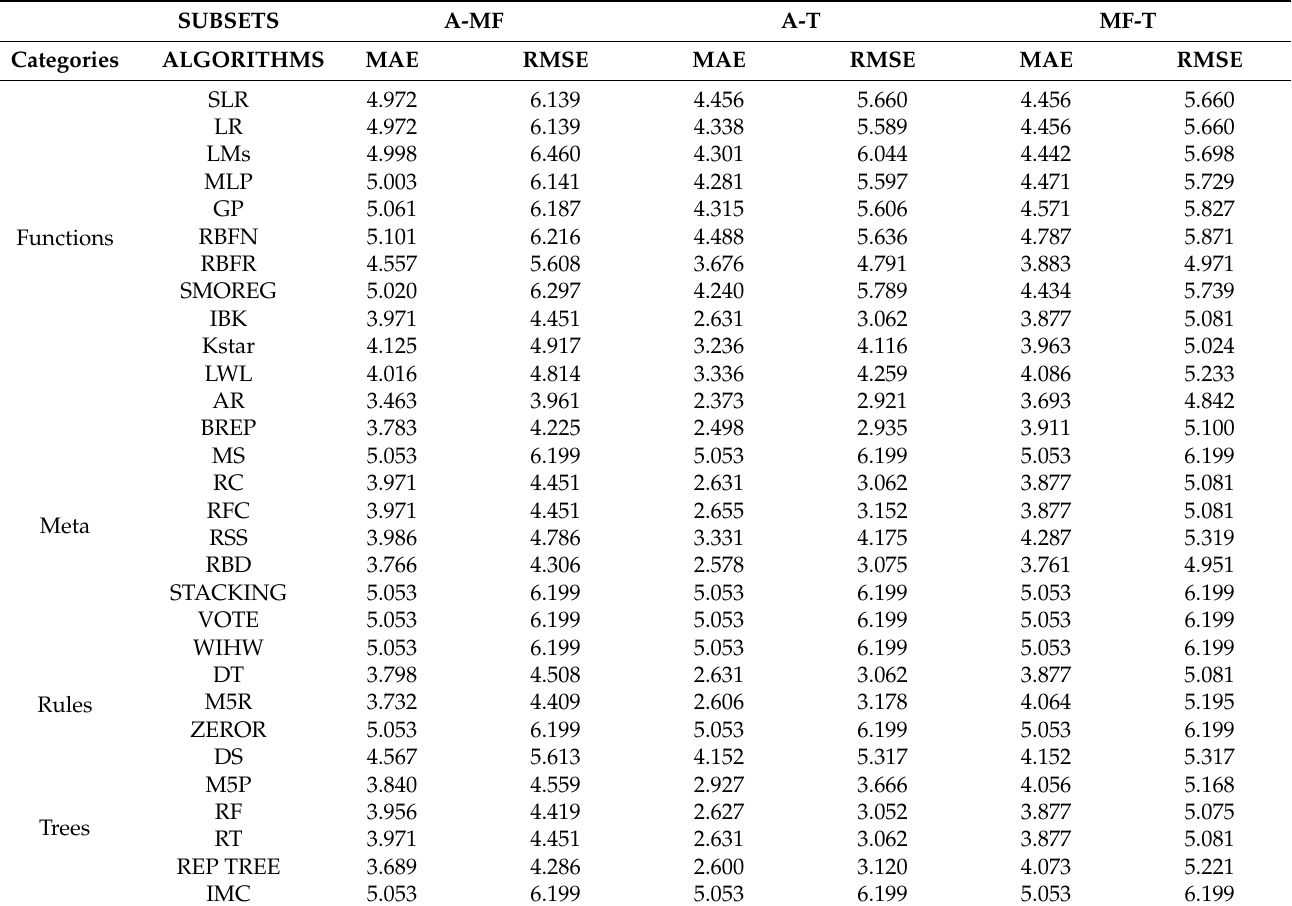
Table 6. Subsets with two